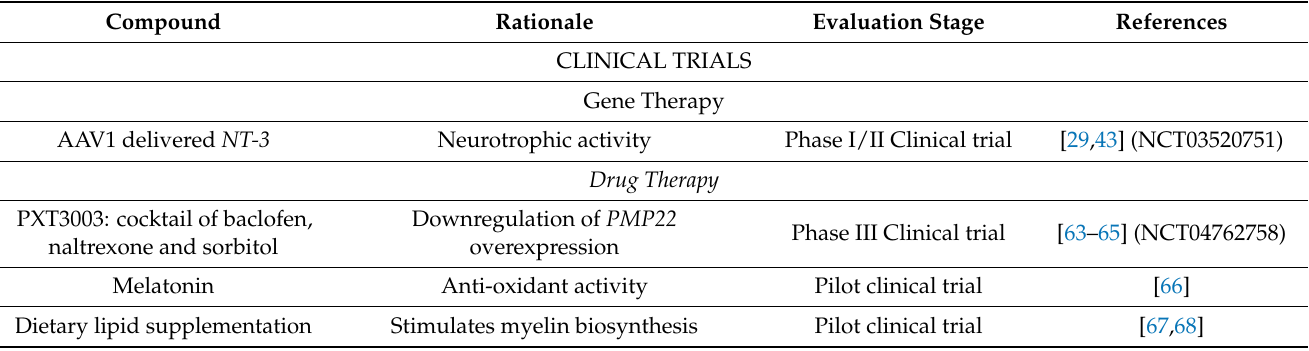
Table 1. Clinical and pre-clinical stage emerging treatments for